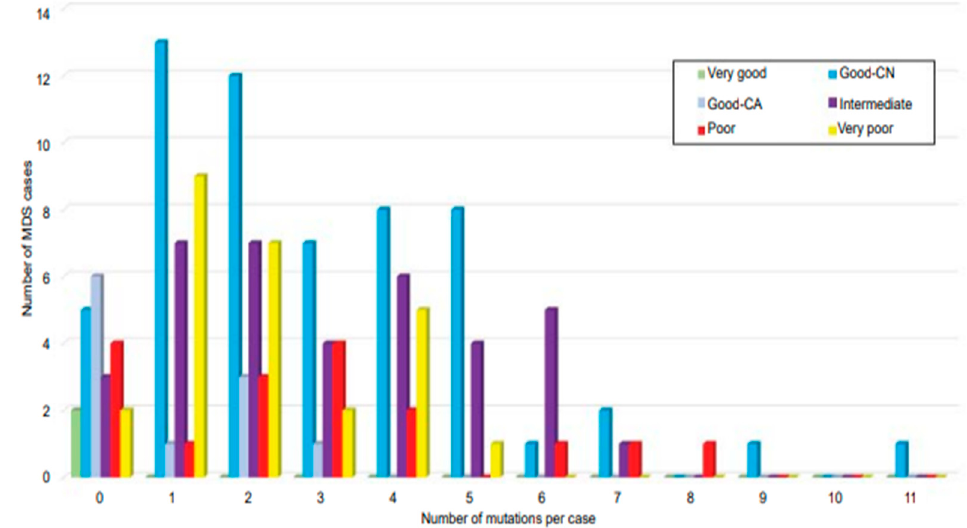
Figure 4. Correlation of number of co-mutations in cytogenetic prognostic-stratified MDS. Two or more mutations identified in 69% of cytogenetically normal MDS (blue), occurring in up to 11 mutant genes in a single patient. Adapted from Tria et al [58] .